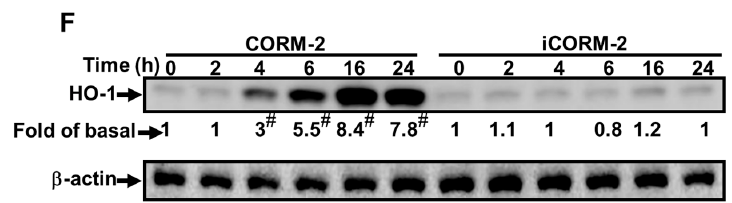
Figure 2. Reactive oxygen species (ROS) are required for CORM-2-induced HO-1 expression in HTSMCs. ( A ) Cells were pretreated with N-acetyl cysteine (NAC) for 1 h and then incubated with CORM-2 for 24 h. The protein levels of HO-1 and β -actin (served as an internal control) were determined by Western blot. ( B ) Cells were pretreated with NAC (10 mM) for 1 h, and then incubated with CORM-2 for 6 h. The mRNA expression of HO-1 was determined by real-time PCR. ( C ) Cells were incubated with the 2',7'-dichlorofluorescin diacetate (DCF-DA) (5 μ M) for 45 min, followed by stimulation with 50 μ M of CORM-2 for the indicated time intervals. ( D ) Cells were pretreated without or with NAC (10 mM) for 1 h before exposure to CORM-2 for 6 h. ( C , D ) The fluorescence intensity of cells was determined. ( E ) DCF-DA, and dihydroethidium (DHE) staining, cells were treated with CORM-2 for 6 h in the absence or presence of NAC (10 mM). The fluorescence images were observed by a fluorescence microscope. Image of fluorescence microscope, 400×. ( F ) Cells were treated with 50 μ M of CORM-2 or iCORM-2 for the indicated time intervals. The protein levels of HO-1 were determined by Western blot. Data are expressed as mean ± SEM of five independent experiments ( n = 5). # p < 0.05, as compared with the cells exposed to vehicle ( C , F ) or CORM-2 ( A , B , D ) alone. Data analysis and processing are described in the section “Statistical Analysis of Data”.